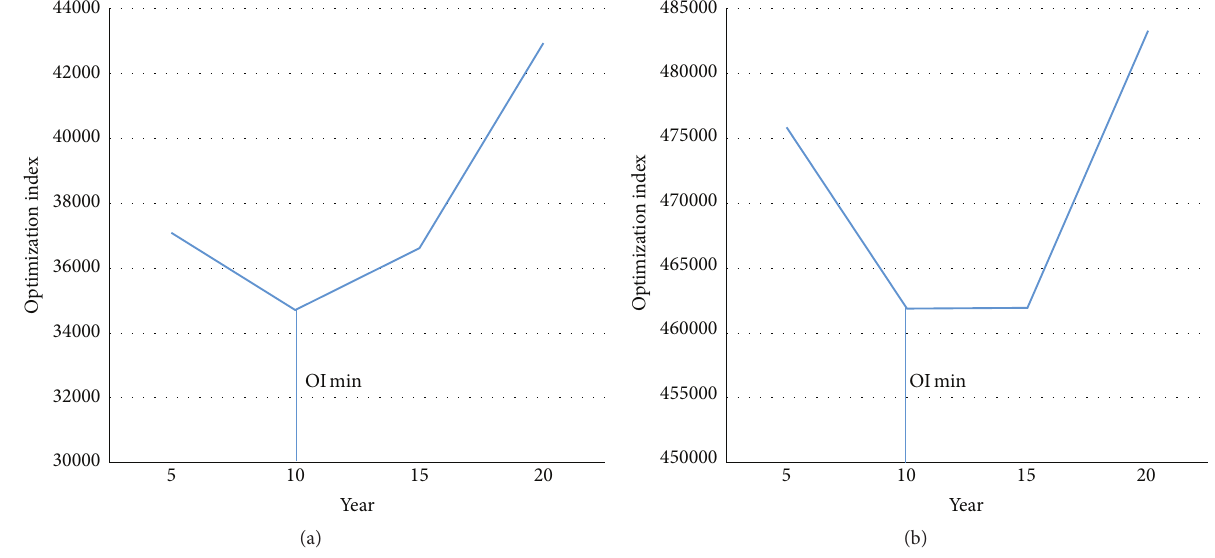
Figure 10: Optimization index calculation. (a) CBA without user cost; (b) CBA with user